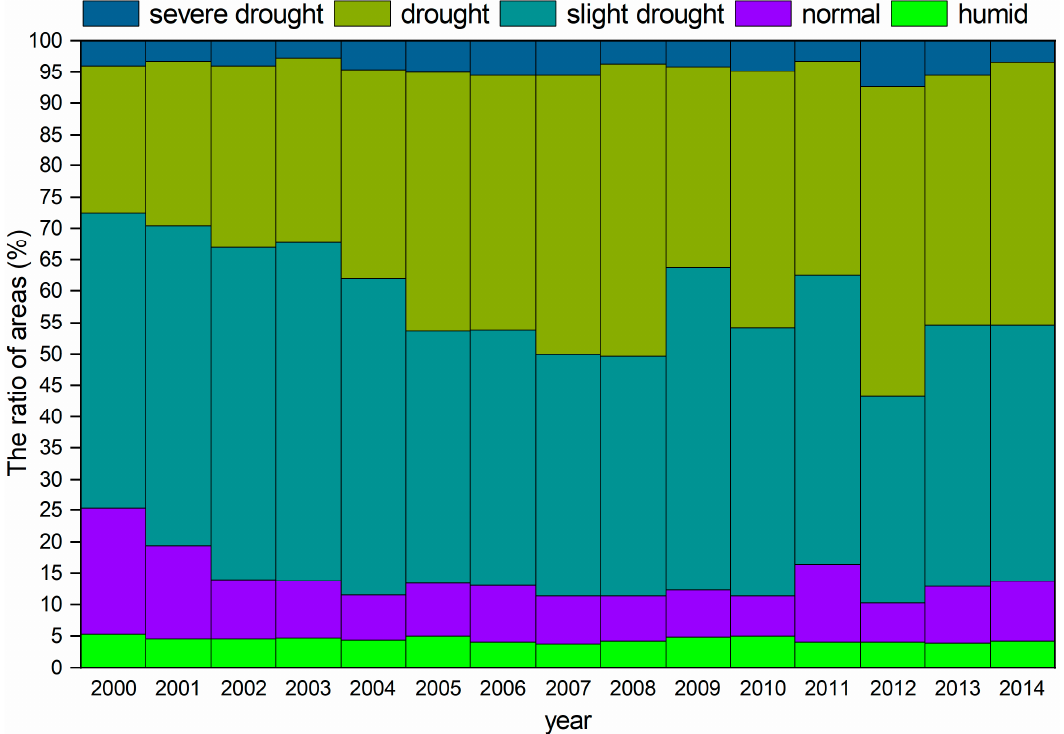
Figure 2. The area ratios of different drought levels from 2000 to 2014.